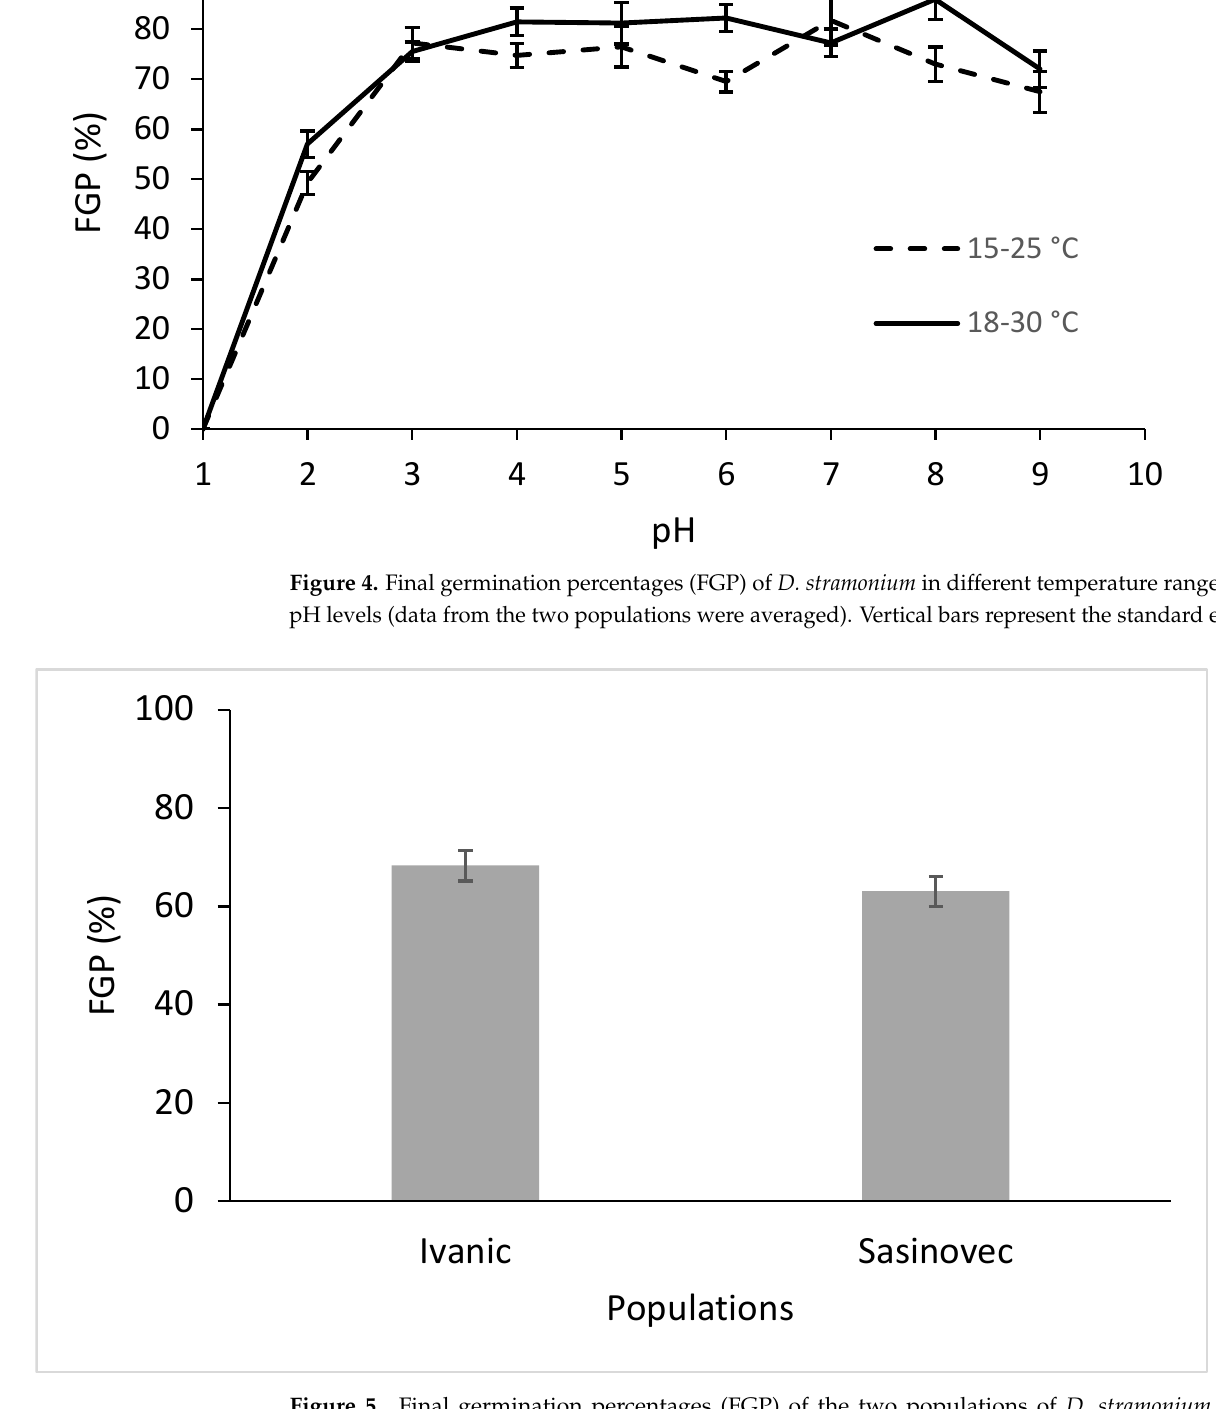
Figure 5. Final germination percentages (FGP) of the two populations of D. stramonium (data for the different temperature ranges and pH levels were averaged). Vertical bars represent the standard errors.